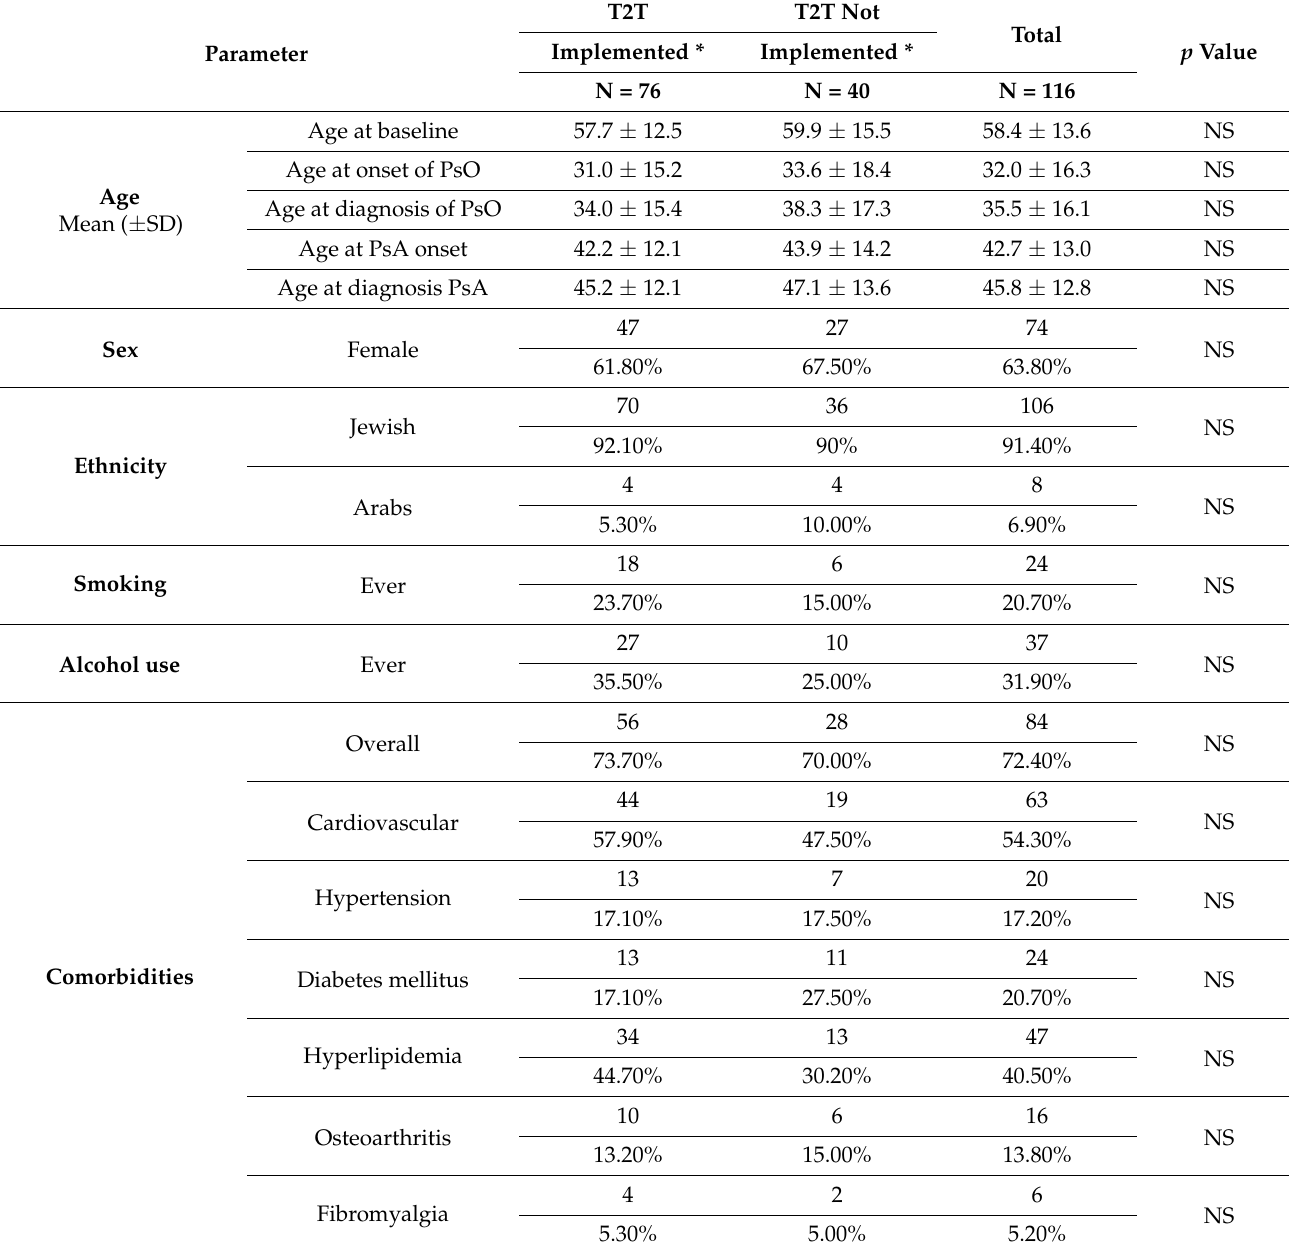
Table 1. Study population